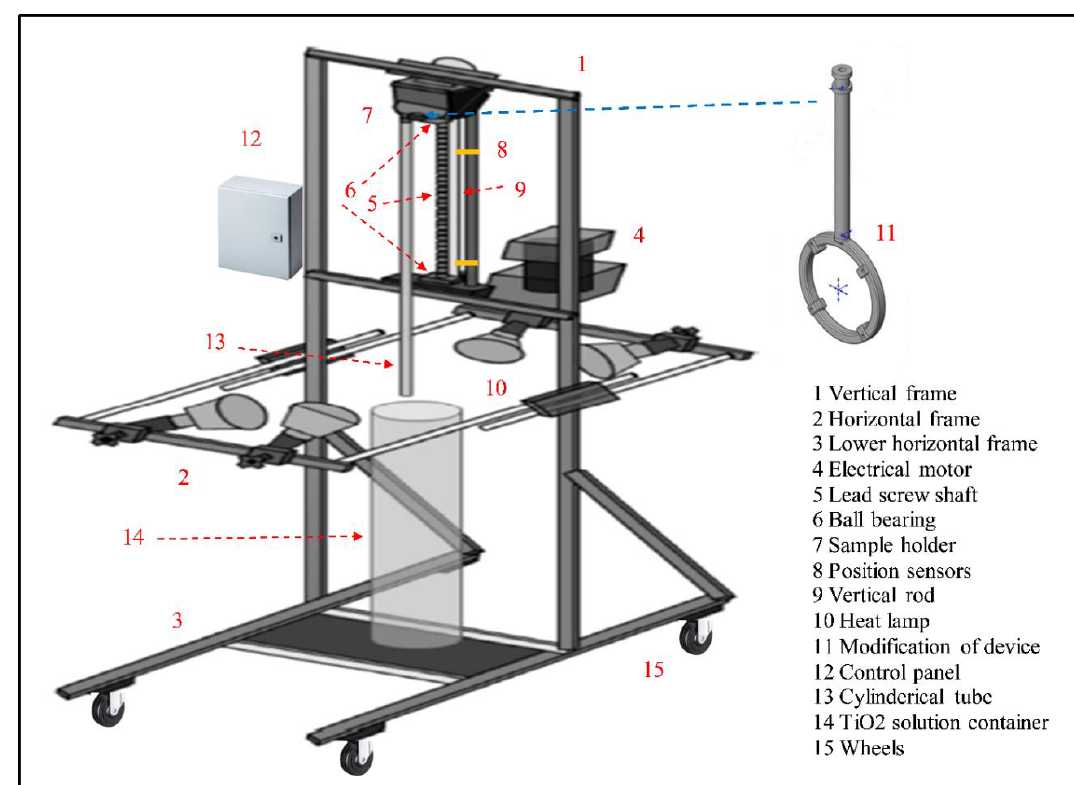
Figure 3. Dip-coating device details